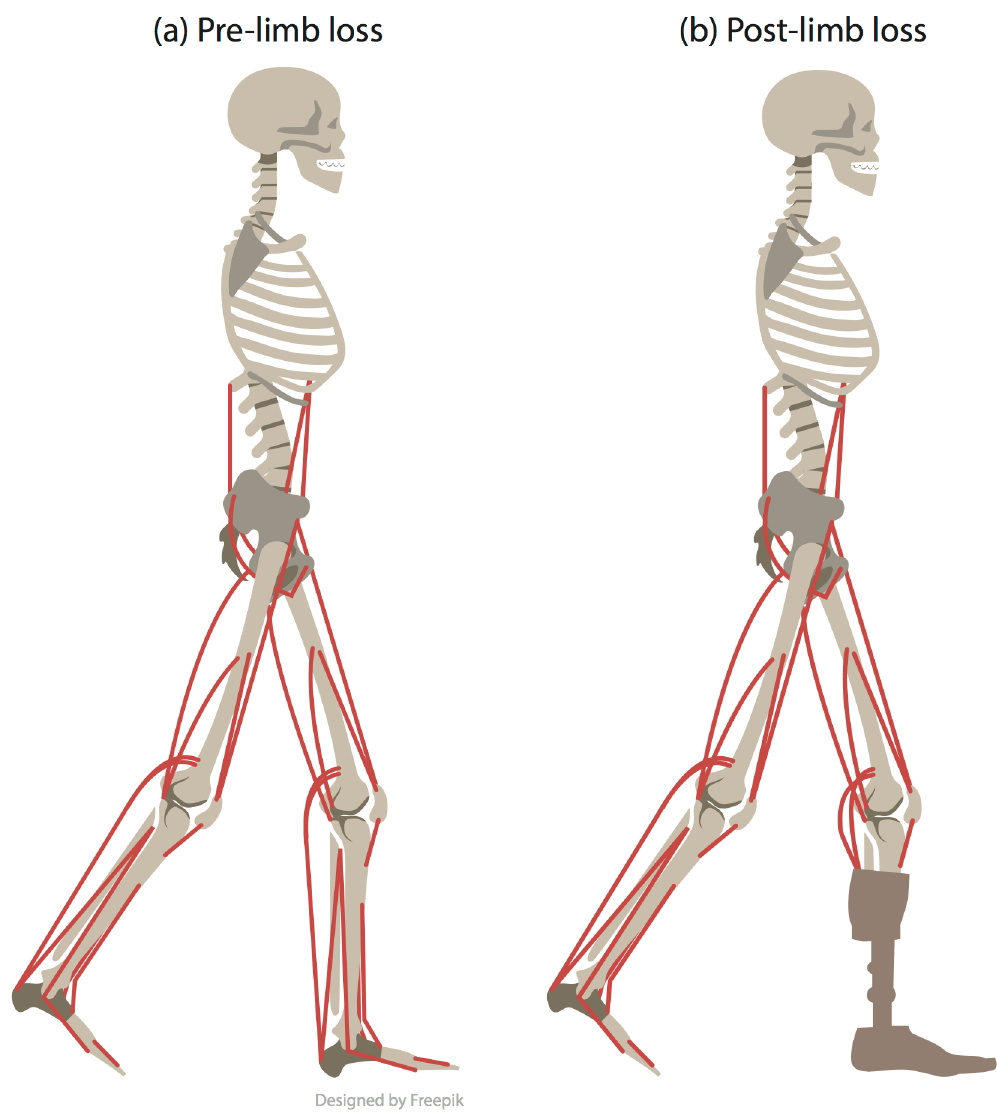
Fig 1. Model drawings. Conceptual drawings of (a) the pre-limb loss model and (b) the post-limb loss model, with the right ankle muscles removed and replaced with a transtibial prosthesis. The sample size was chosen based on pilot data from a preliminary sample of 20 simulated subjects that suggested a sample size of 25 could detect differences in metabolic cost with and without limb loss of 9–33% as statistically significant ( p < 0.05) with 80–99% power. This range (9–33%) is the range typically reported by studies on the general population of individu- als with unilateral transtibial limb loss [10]. The study was therefore powered to detect differ- ences of the size seen in the general population as “significant” and differences of the size seen in the Service Member population as “insignificant”, similar to results from gait experiments with human subjects. The approach to modeling limb loss (§2.2) was the same for all subjects. Overview. A total of 385 simulations were performed: 10 validation simulations, plus 25 subjects with 15 simulations per subject. In all simulations, the models described in §2.1–2.2 were used to simulate a periodic stride of walking with stride duration T and average speed v .